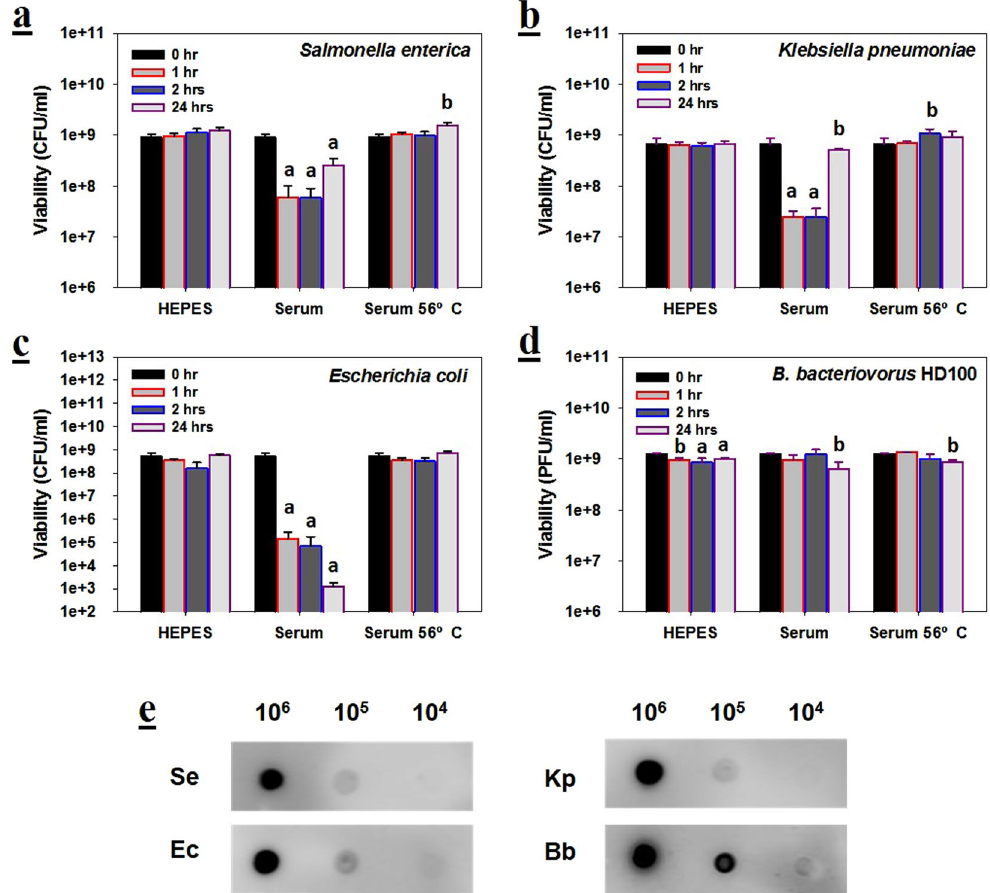
Figure 1. Serum complement does not significantly impact B. bacteriovorus HD100 viabilities. Viability of ( a ) S. enterica , ( b) K. pneumoniae , ( c ) E. coli and ( d ) B. bacteriovorus HD100 in HEPES, 50% serum or 56 °C-treated serum (50%; complement inactivated) for up to 24 hours. p < 0.001 for a; p < 0.01 for b. n = 3. ( e ) Dot-blot results showing the serum possesses antibodies against each of the bacterial strains, particularly B. bacteriovorus HD100. Each spot contained between 2.5 × 10 4 and 2.5 × 10 6 bacteria per spot. The spots were probed using whole human serum and then with a peroxidase-conjugated anti-human goat